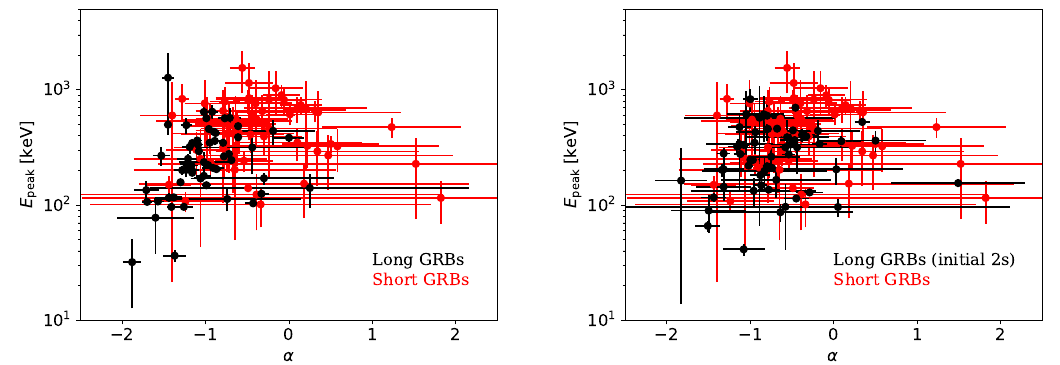
Figure 2. Distribution of E peak versus α between long GRBs and short GRBs ( left ), and the initial 2 s of long GRBs and short GRBs ( right ).